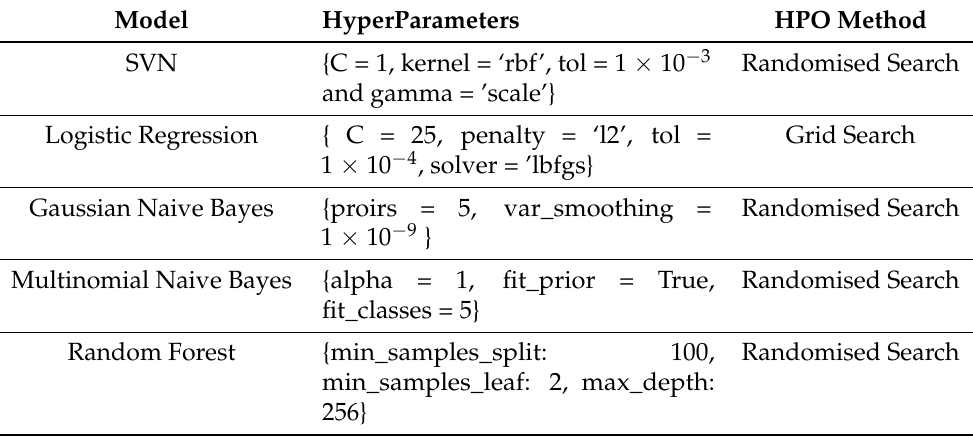
Table 1. Hyperparameters selected per